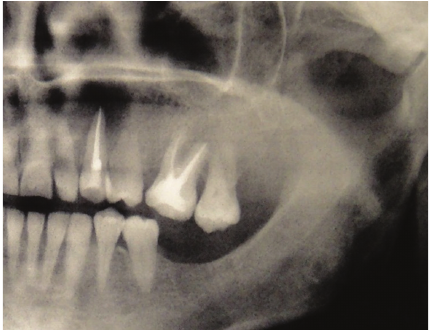
Figure 1: Panoramic radiograph revealing a radiolucency of about 2cm of diameter in the periapical region of the endodontically treated left canine.